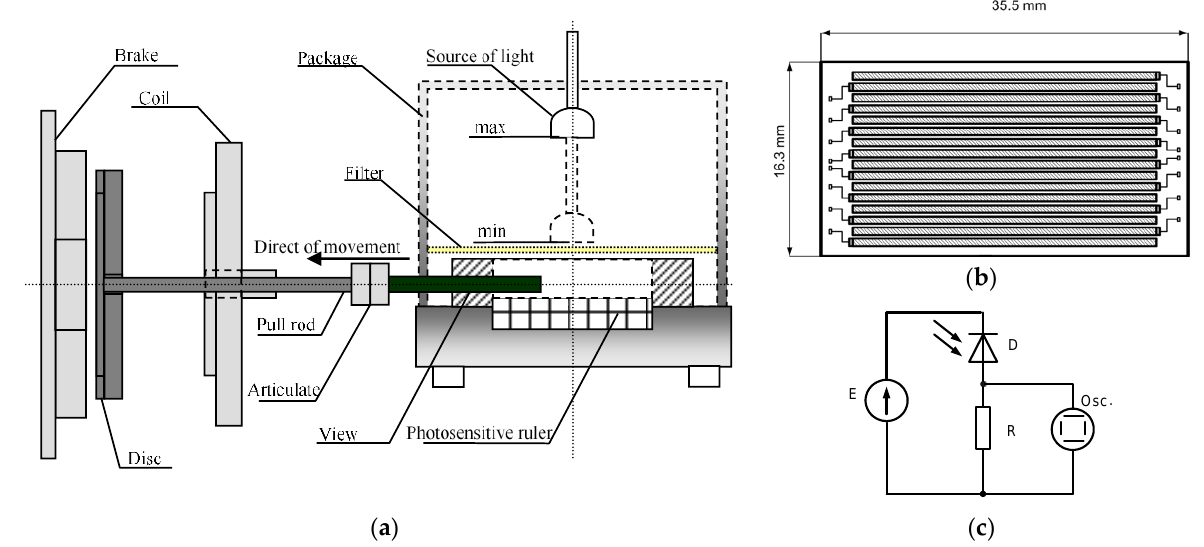
Figure 3. Photoelement ( a ) view of construction, ( b ) matrix structure of photosensitive ruler, and ( c ) photodiode system.